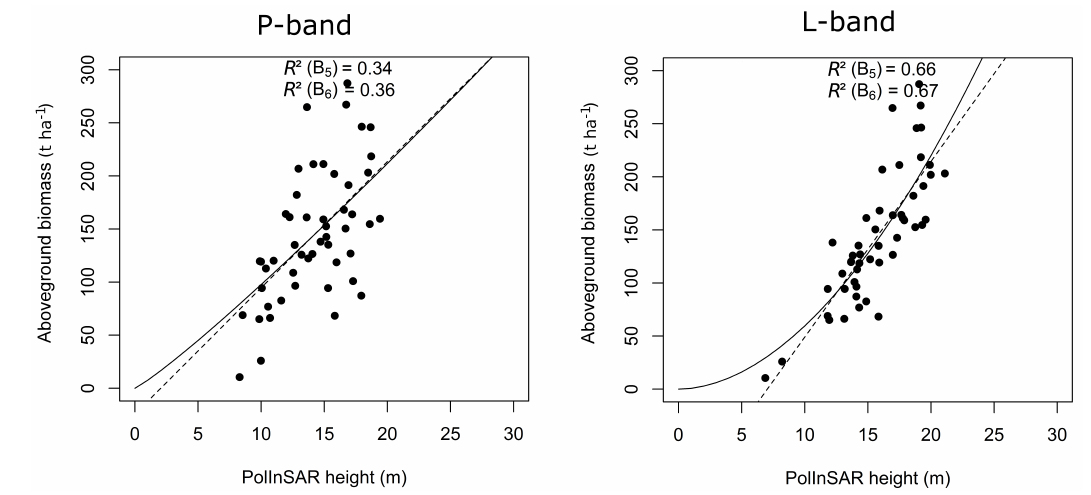
Figure 5. PolInSAR height and aboveground biomass regression based on P- ( left ) and L-band ( right ) in Remningstorp (Data acquired on 2 May